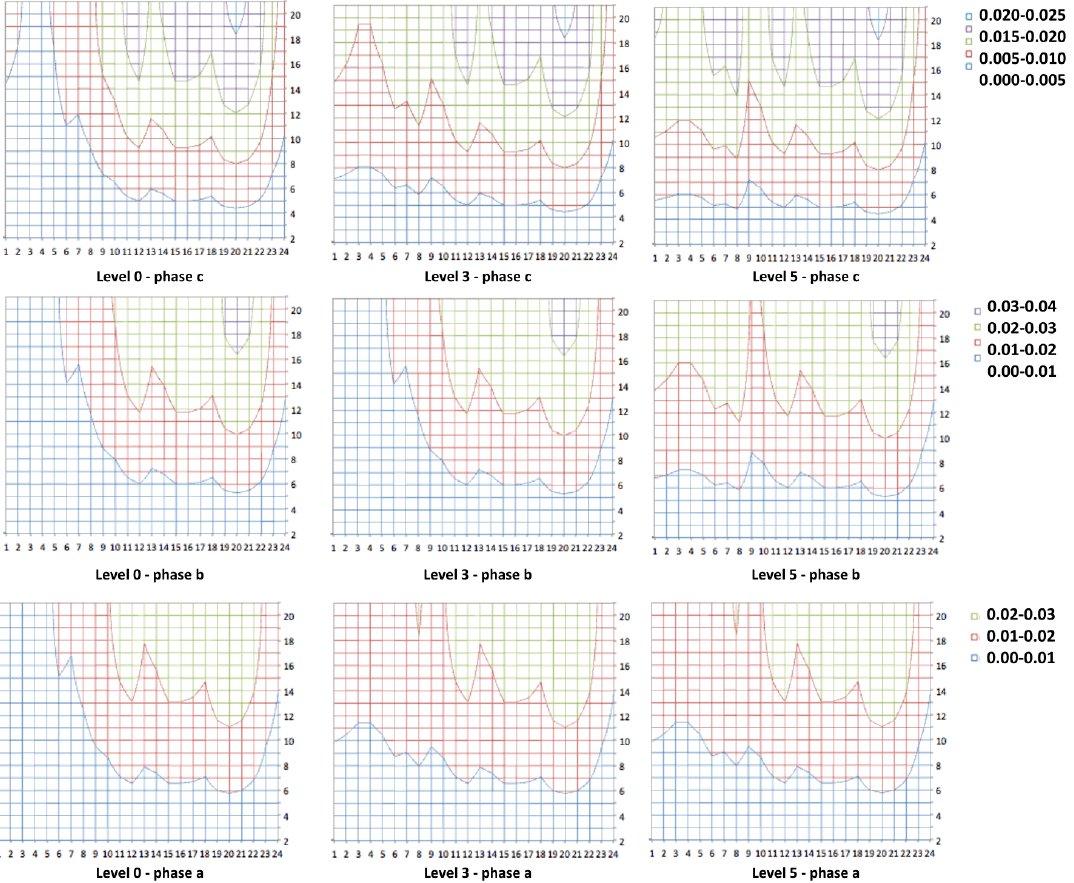
Figure 6. Off-peak load scenario: MLCs pattern by node and by time (Levels 0, 3 and